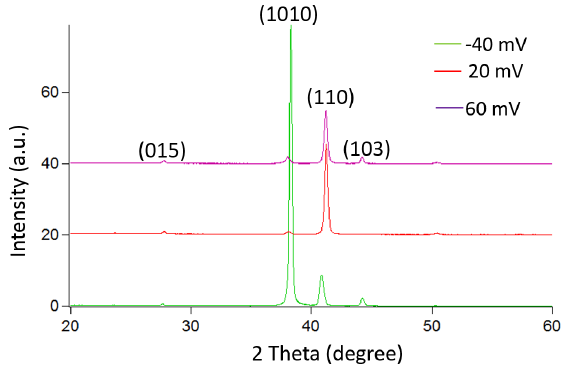
Figure 13. XRD pattern of the BiTe films with different deposited potentials.